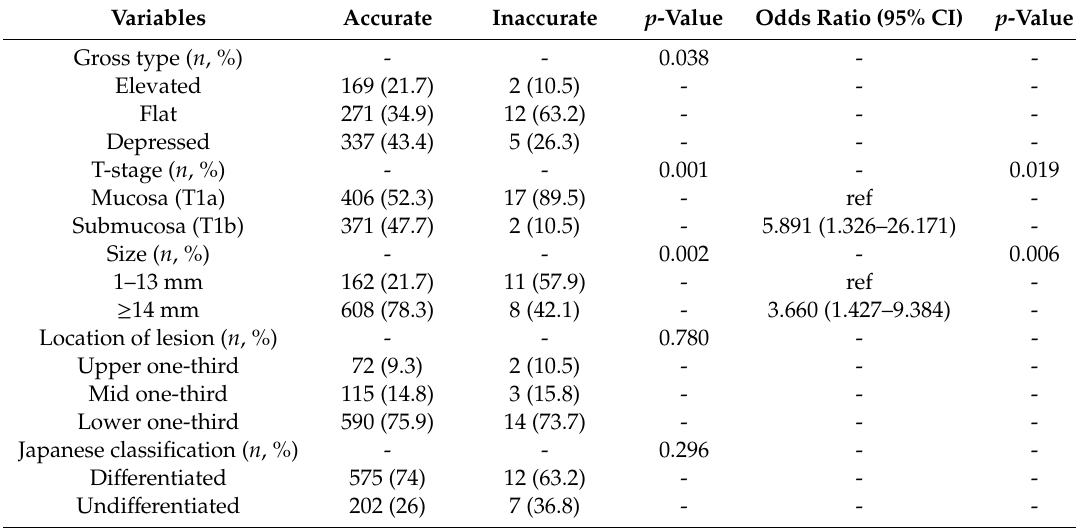
Table 2. Factors a ff ecting the accuracy of tumor detection.